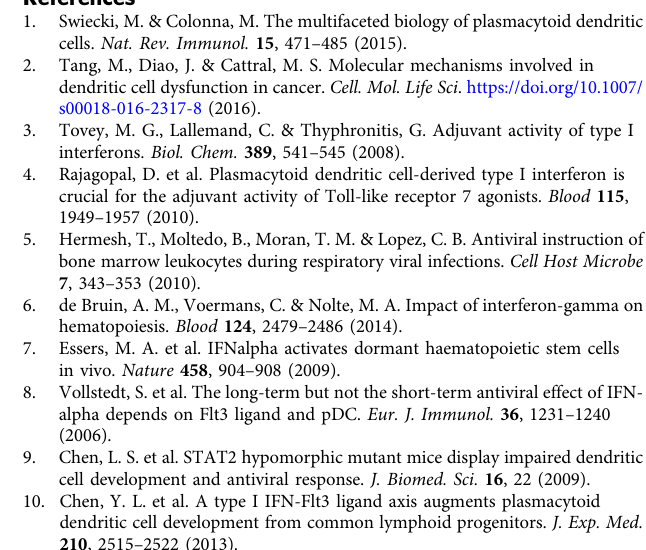
table 2. Data were analyzed using FlowJo software (version 10, Tree Star, Ashland, OR, USA). Individual gating strategies are depicted in relevant fi gures and outlined in fi gure legends. FMO controls were utilized to distinguish different